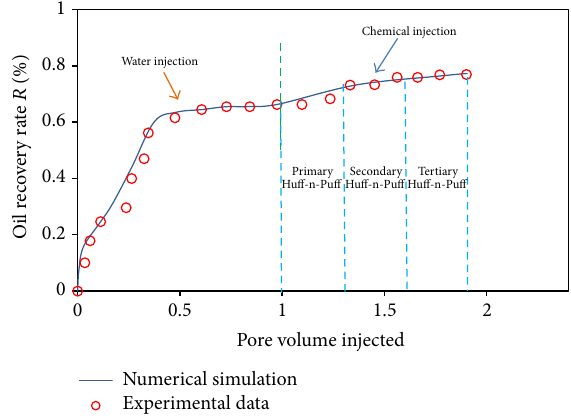
Figure 8: The oil recovery rate of surfactant flooding (at a tempera- ture of 60 ∘